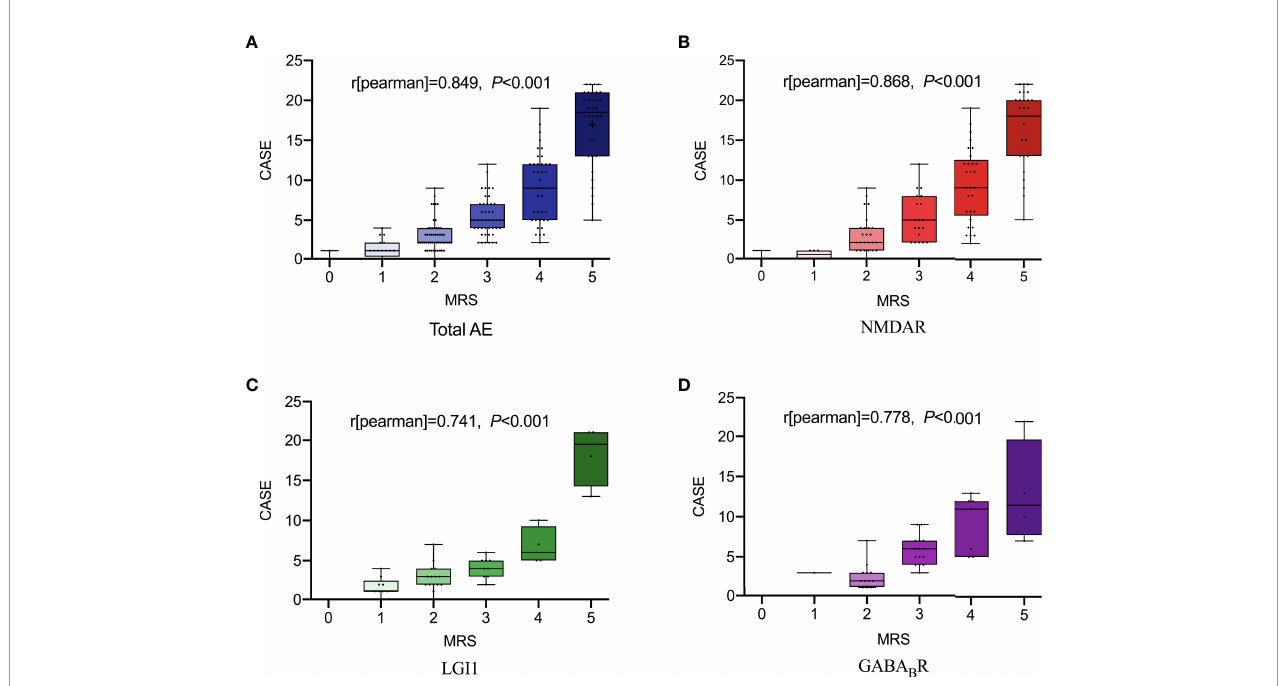
FIGURE 3 | The total scores of the CASE according to the mRS. Total AE, NMDAR, LGI1 and GABA B R (A-D) . AE, autoimmune encephalitis; NMDAR, N-methyl-D- aspartate receptor; LGI1, leucine-rich glioma inactivated 1; GABA B R, g -aminobutyric acid type B receptor; CASE, The Clinical Assessment Scale for Autoimmune Encephalitis; mRS, modi fi ed Rankin